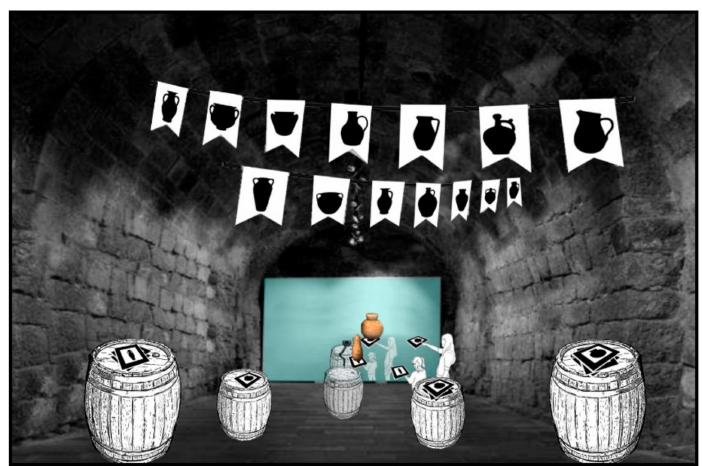
Figure 2. Sketch of the TinajAR concept for the Calado del Conde , in Navarrete, La Rioja,